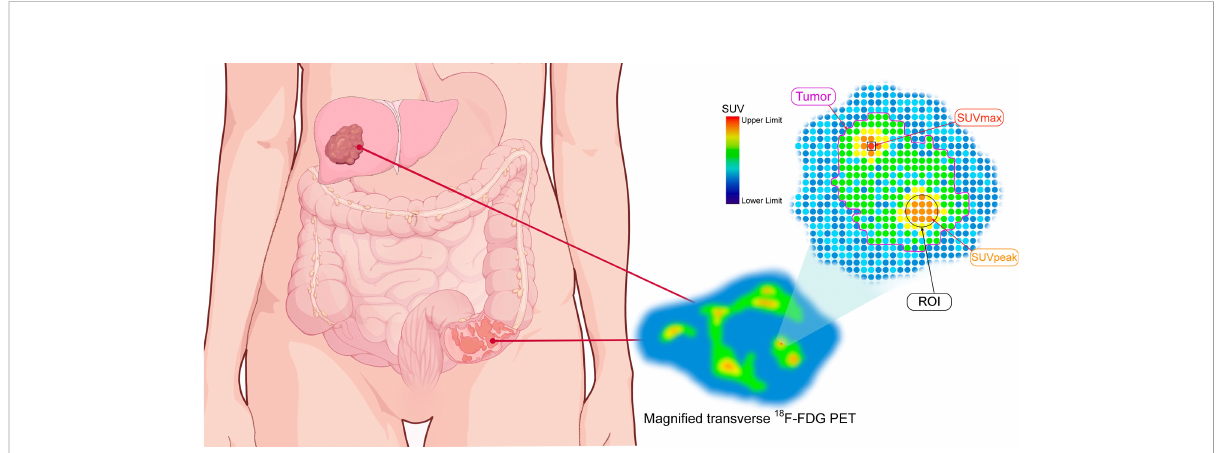
FIGURE 2 The schematic diagram of quantitative parameters of PET. The magni fi ed transverse 18 F-FDG PET image of radiotracer uptake in tumor (purple outline). SUVmax: maximum standardized uptake value (red spot within black square); ROI: region of interest (black circle); SUVpeak: the average SUV obtained from a 1mL sphere within the